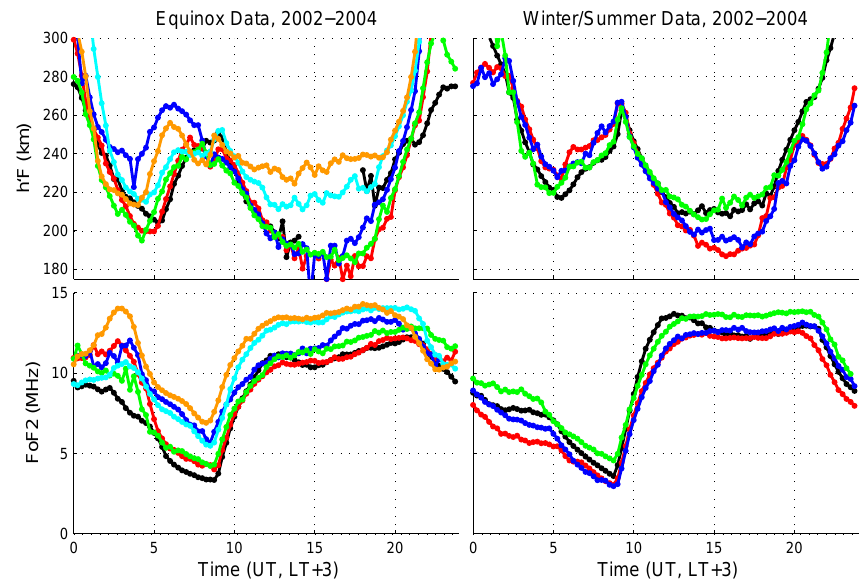
Fig. 4. Monthly averages of fo F2 (left) and h 0 F binned into equinox and winter summer months as measured in Palmas, Brazil.